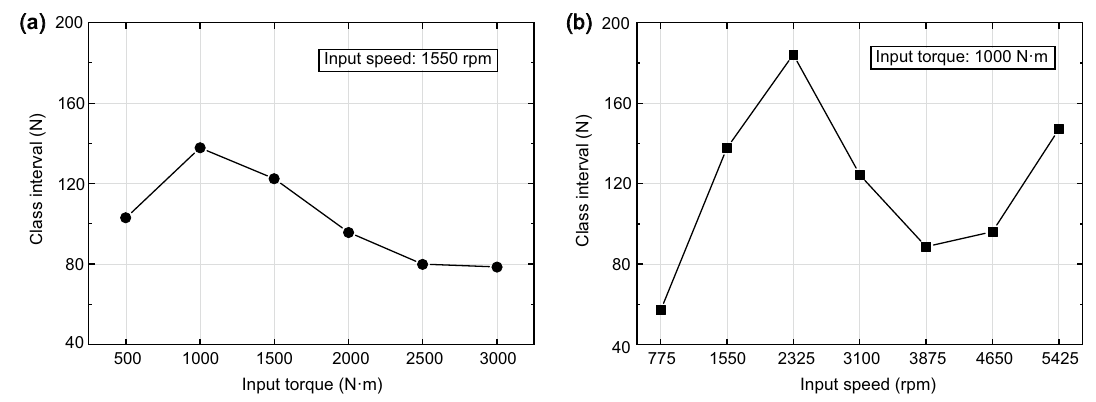
Fig. 12 Class intervals of the measured bearing load spectra under conditions of a different torques and b different speeds